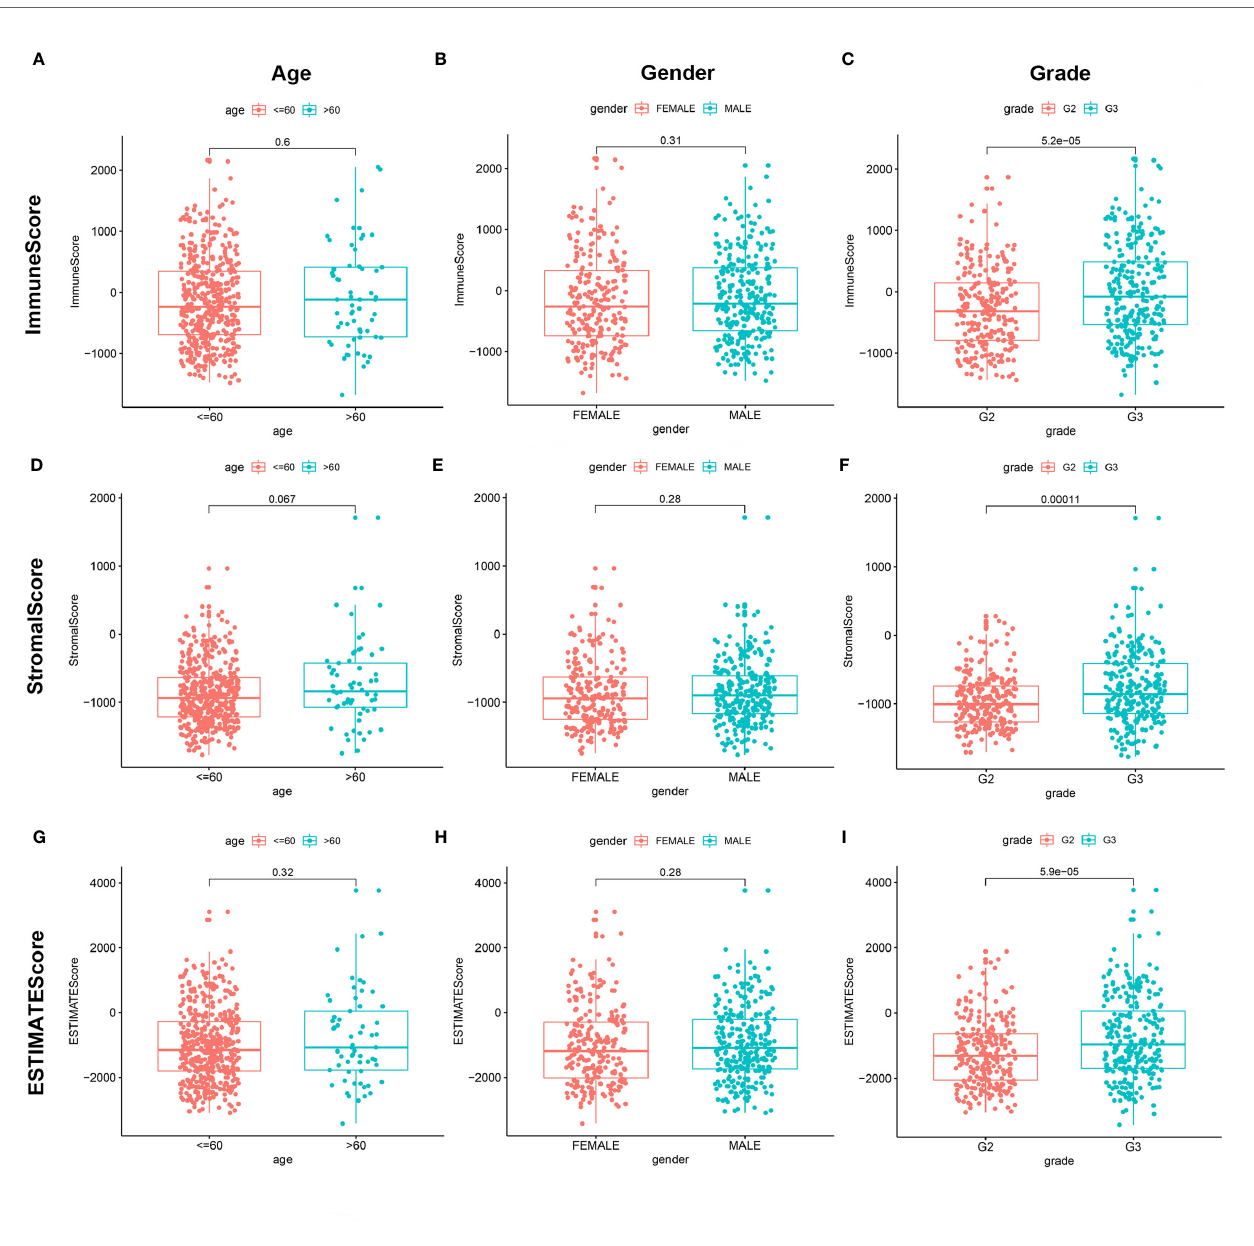
FIGURE 3 | Correlation of ImmuneScore and StromalScore with clinicopathological staging characteristics. (A, D, G) Distribution of ImmuneScore, StromalScore, and ESTIMATEScore in age. P = 0.6, 0.067, and 0.32. (B, E, H) Distribution of three kinds of scores in gender. P = 0.31, 0.28, 0.28. (C, F, I) Distribution of scores in grade. P <